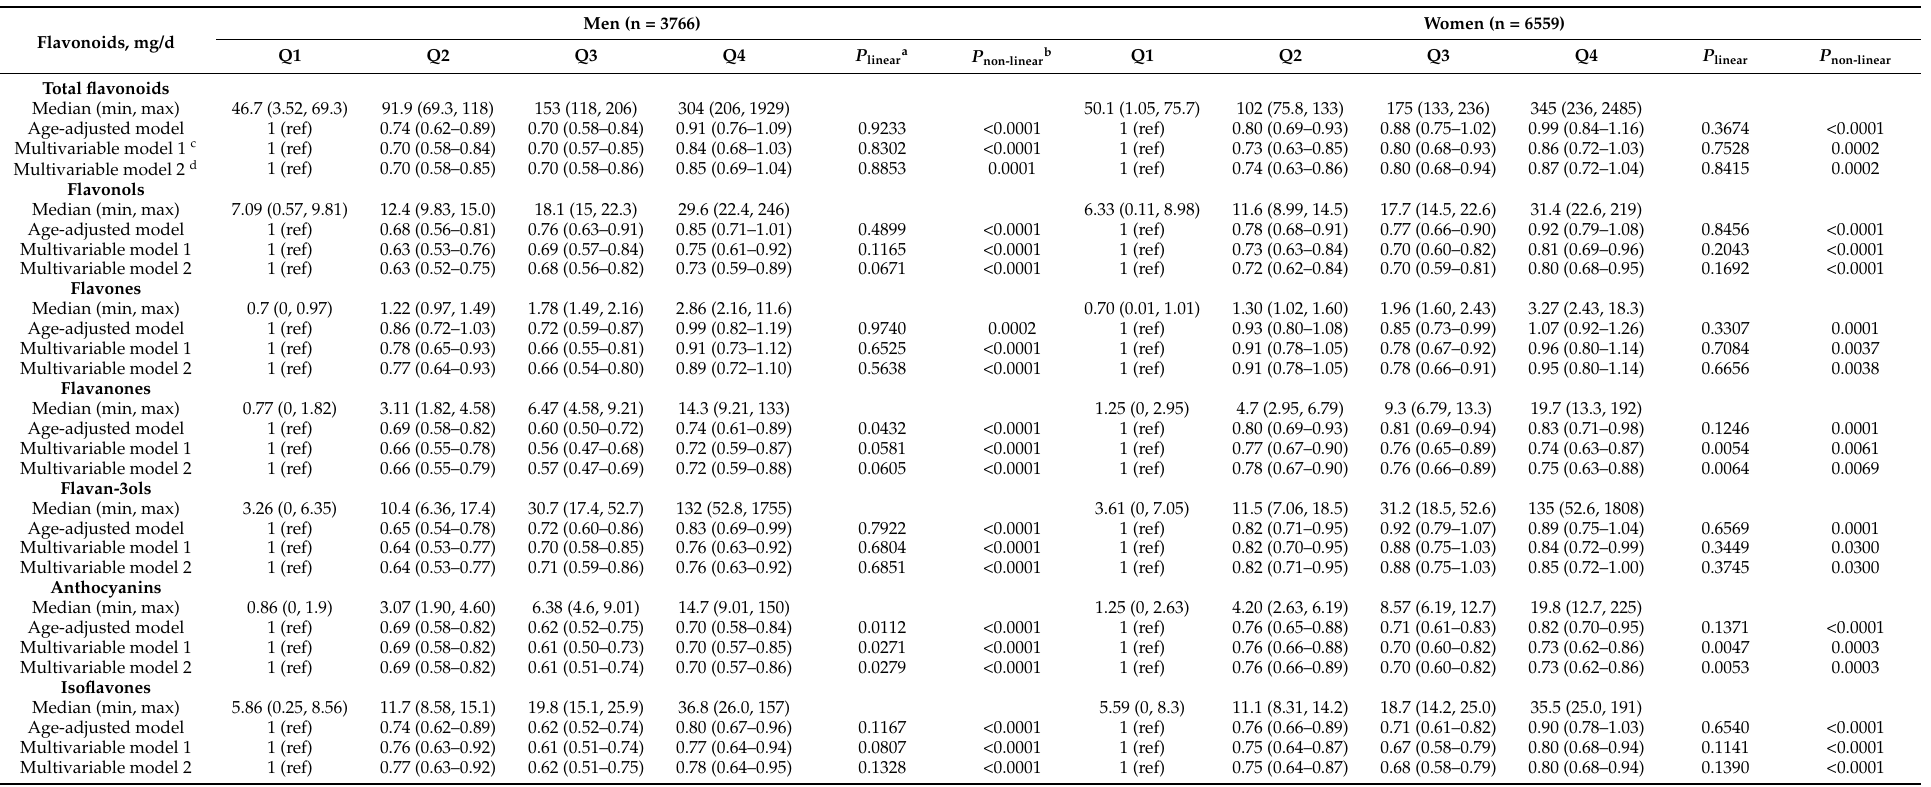
Table 2. Incident Rate Ratios (IRRs) and 95% Confidence Intervals (CIs) of hypertension by quartiles of dietary intakes of flavonoids and its subclasses (n =